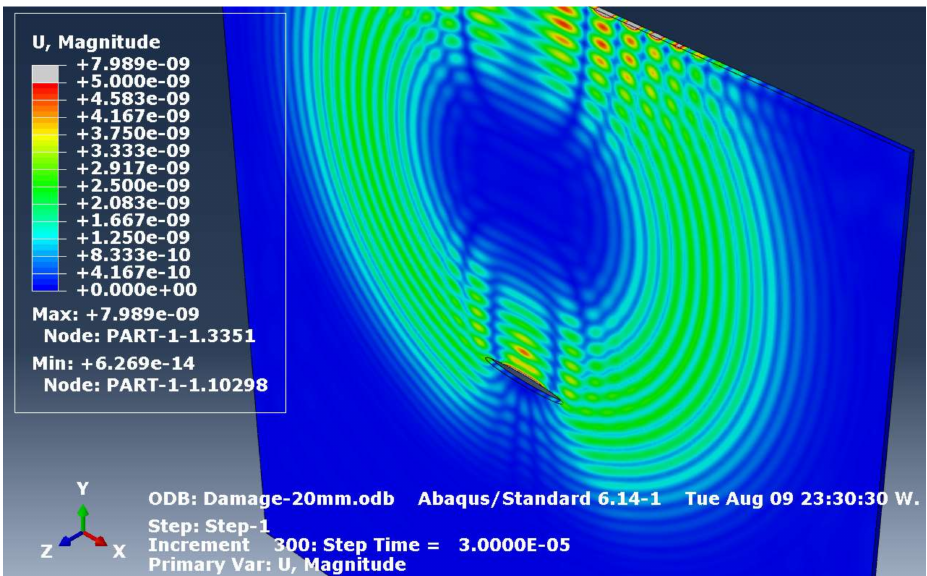
Figure 2. Lamb wave propagation at the step time of 30 µ s after excitation in an Al-7075-T6 plate with dimensions of 200 mm × 200 mm × 1 mm. (shown in ABAQUS GUI Viewer. Note that there is no ‘unit’ in ABAQUS). The default scientific notation of displacement magnitude ‘e-09’ means [nm]. Displacement magnitude shown in grey color signifies displacement above 7.989